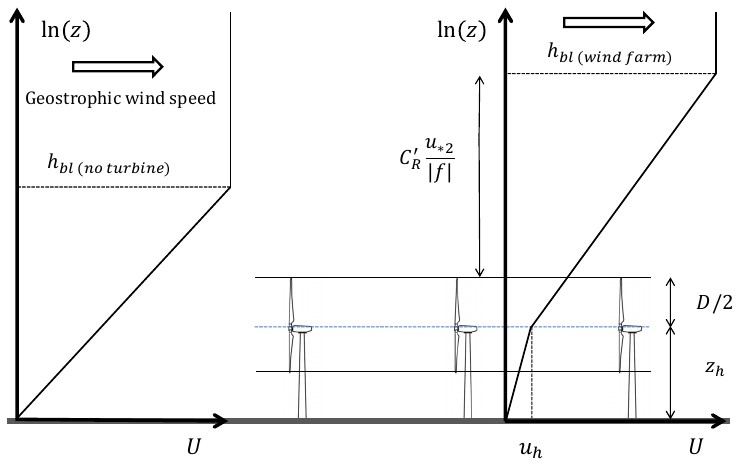
Figure 11. A schematic of wind profile inside a very large wind